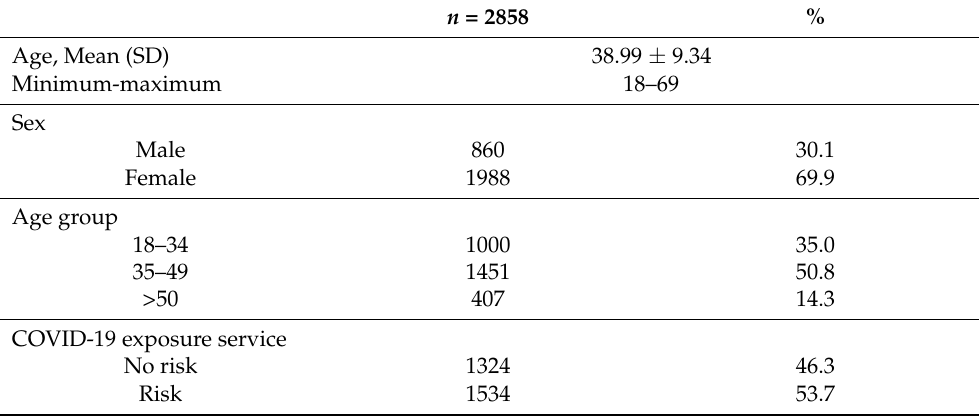
Table 1. Demographic characteristics of health professionals in the Elche-Crevillente and Torrevieja health